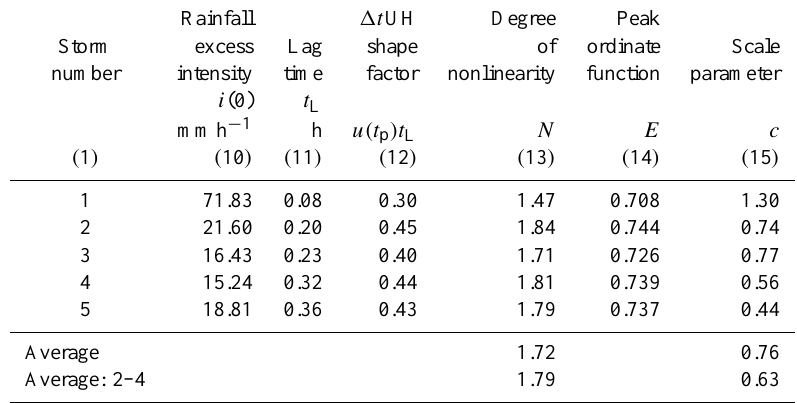
Table 2b. Unit hydrograph data for the Edwardsville catchment. Variable instantaneous unit hydrograph (IUH) model parameters. Rainfall 1t UH Degree Peak Storm excess Lag shape of ordinate Scale number intensity time factor nonlinearity